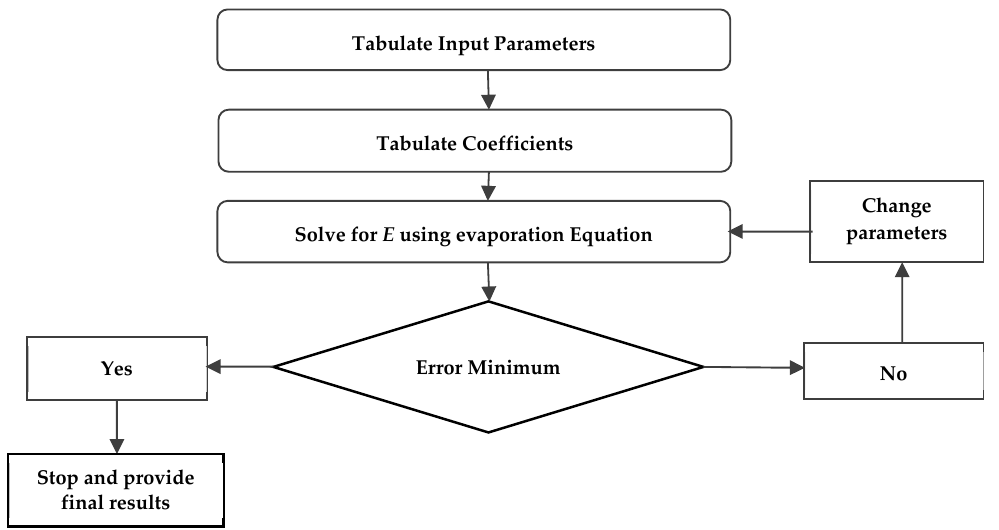
Figure 3. Flow Chart of the General Reduced Gradient Method of Optimization.